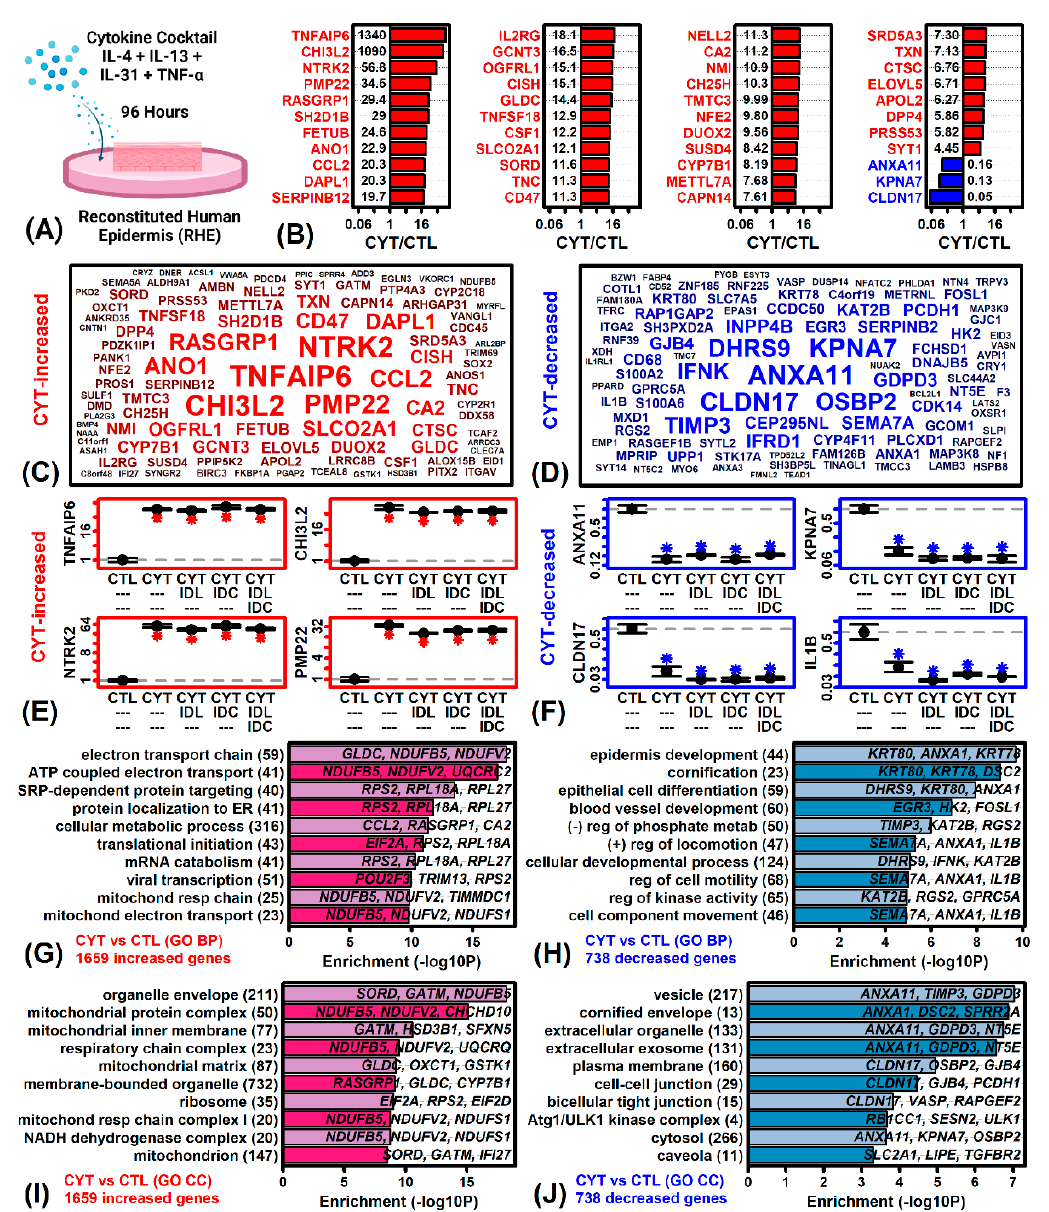
Figure 2. Gene expression response to cytokine cocktail (IL-4, IL-13, IL-31 and TNF- α ) in RHE tissue. ( A ) Experimental design. ( B ) Top 44 DEGs with lowest p -value (ranked according to fold-change). ( C ) Top 100 cytokine-increased DEGs. ( D ) Top 100 cytokine-decreased DEGs. In ( C , D ), genes with larger fonts and blue/red color have lower p -values. ( E ) Cytokine-increased DEG average expres- sion. ( F ) Cytokine-decreased DEG average expression. In ( E , F ), expression scores are normalized to the CTL treatment and an asterisk (*) is used to indicate significant differences compared to the CTL treatment ( p < 0.05, two-sample t -test). ( G , I ) GO BP and CC terms enriched among cytokine-in- creased DEGs. ( H , J ) GO BP and CC terms enriched among cytokine-decreased DEGs. In ( G – J ), the number of DEGs associated with each GO term is indicated in parentheses and example genes are listed within each figure.